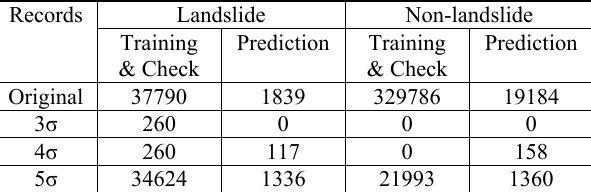
Table 4. Records of test